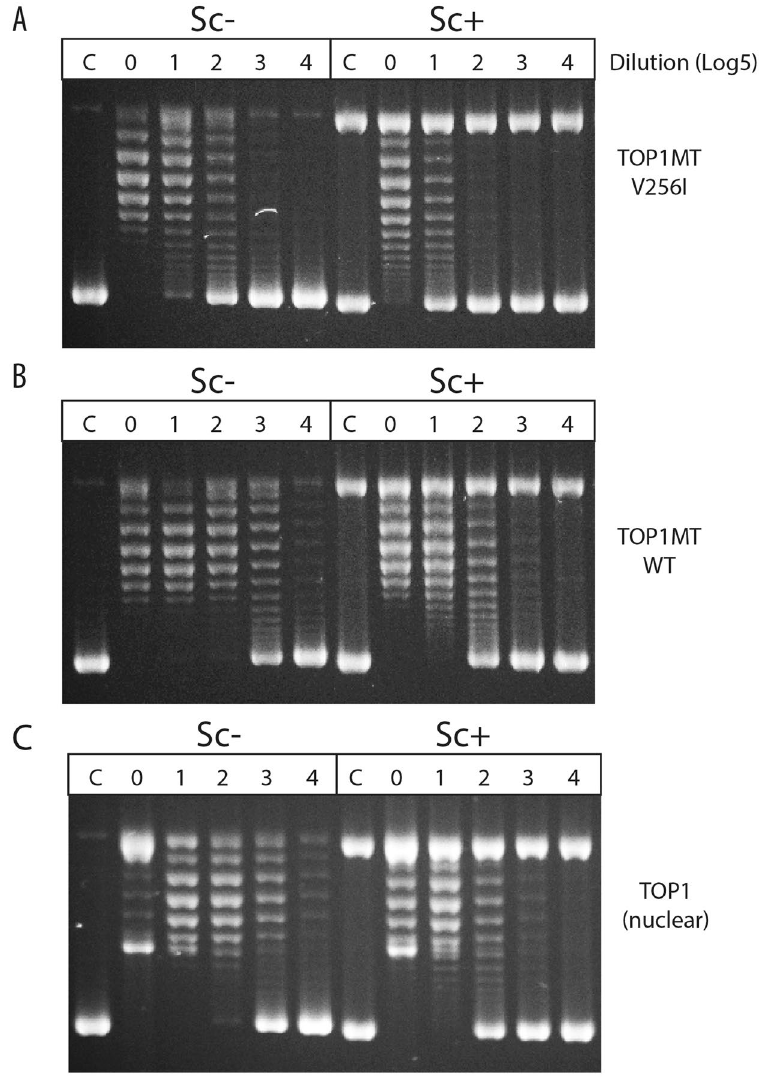
Figure 5. Relaxation assay of TOP1MT, TOP1MT V256I variant, and TOP1 on negatively and positively supercoiled pBR322 DNA. Sc − : Negatively supercoiled pBR322 plasmid DNA; Sc + : positively supercoiled pBR322 plasmid DNA; C, control, no enzyme added; the numbers on top of the figures are dilution factors of corresponding enzymes; 0, no dilution; 1, 1:5 dilution; 2, 1:25 (5 2 ) dilution; 3, 1:125 (5 3 ) dilution; 4, 1:625 (5 4 ) dilution. Representative gels were